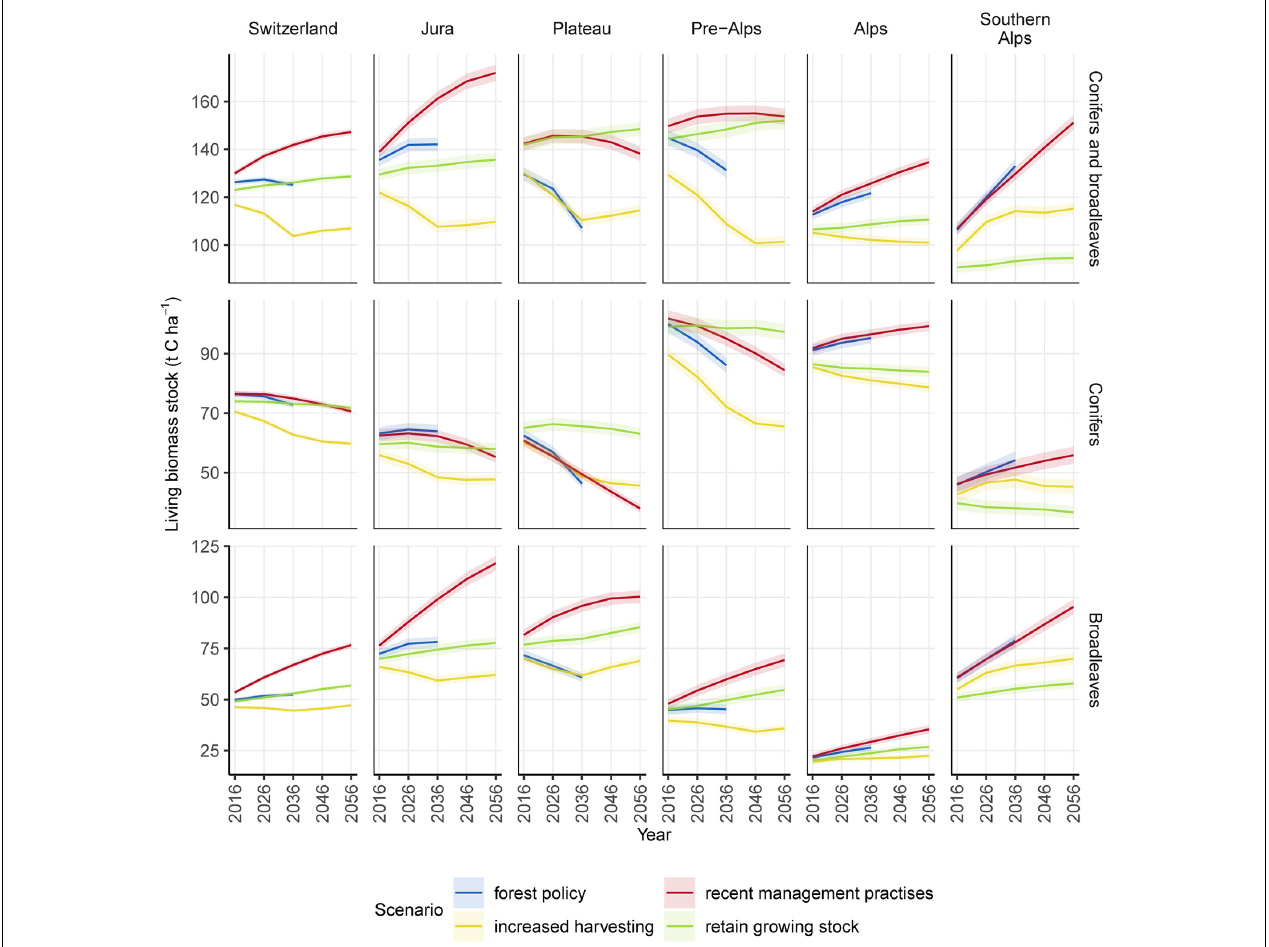
FIGURE 3 | Switzerland’s living biomass stock (above and below ground) for all Switzerland and its production regions. Results of conifers (middle row) and broadleaves (lower row) sum up to the total biomass stock in the upper row. Simulation results include mean (thick line) and Standard Error of 30 replicates (shaded area). The lines between each end of a time-step (e.g., between 2026 and 2036) are linearly